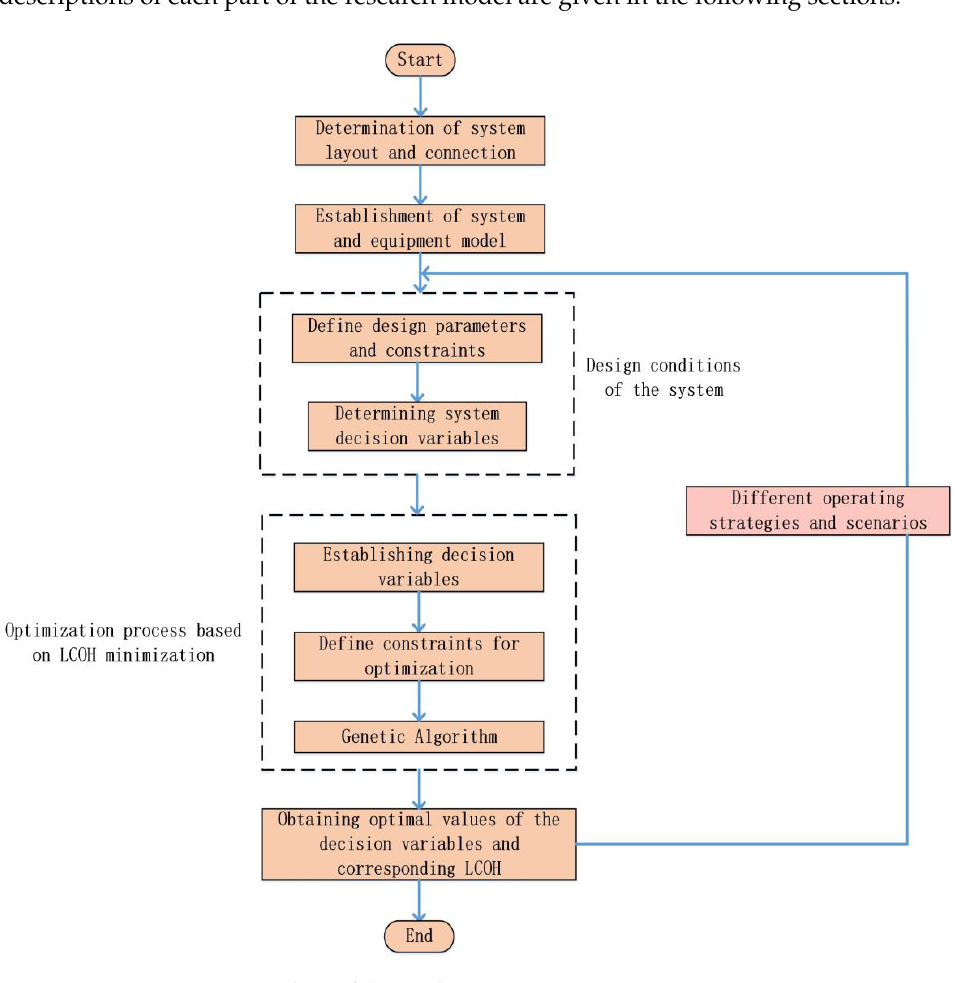
Figure 1. Investigation procedure of the study.